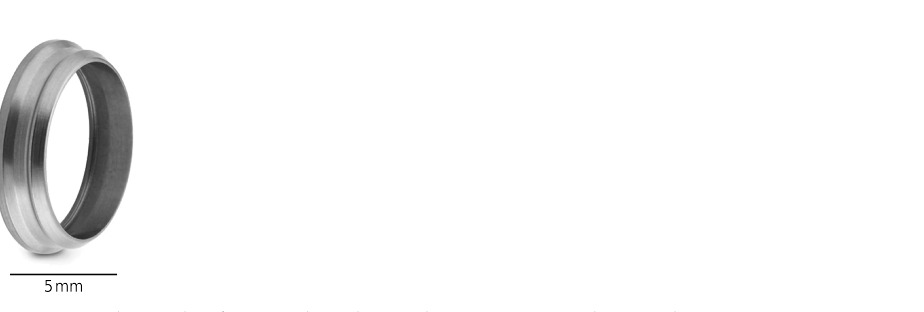
Figure 2. Ferrule, made of a Ni-rich and Cr-rich austenitic stainless steel